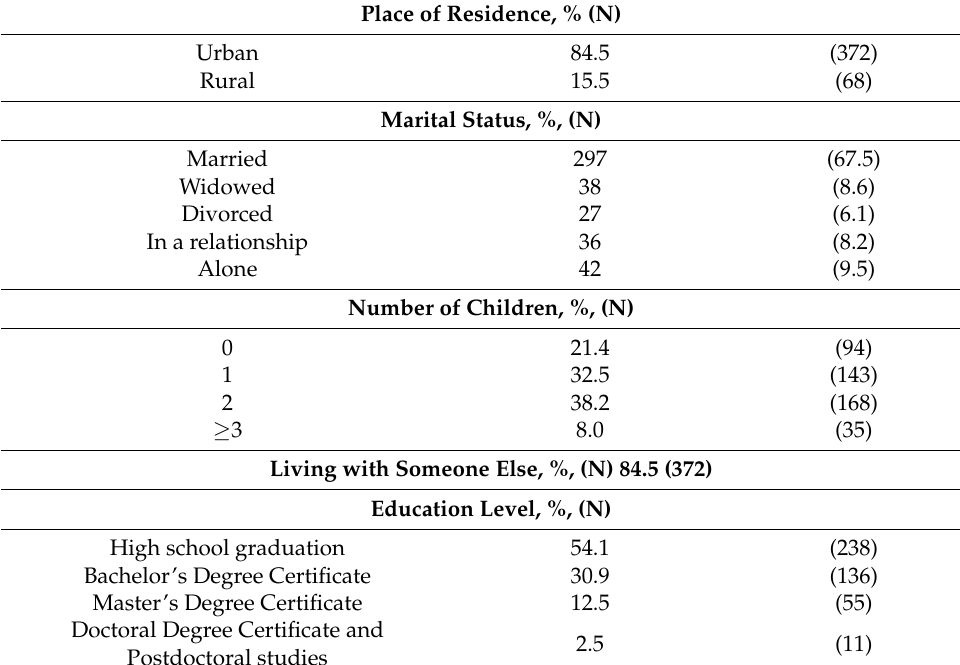
Figure 2. Pyramid of age groups by gender. N = 440, 65.7% female (N = 289); the most representative age group was 35–64 years old (60.5%, N = 266). Table 1. Demographic characteristics.